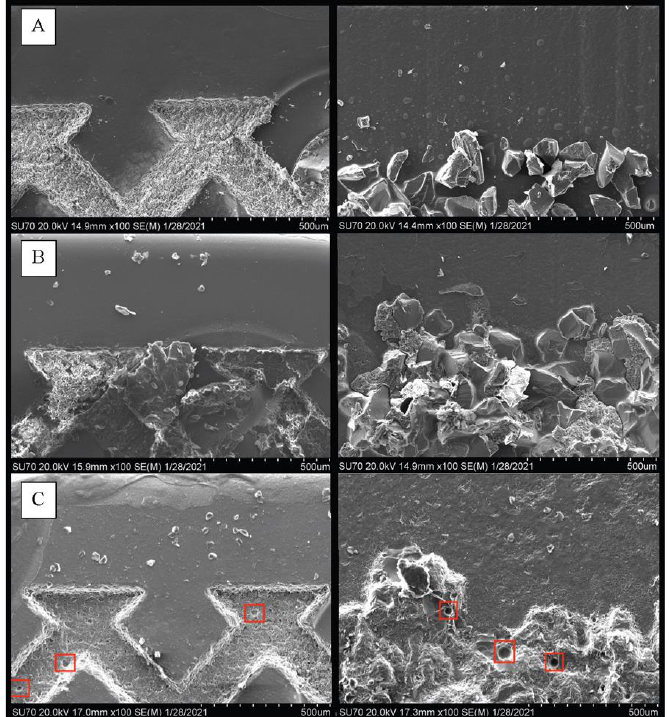
Figure 2. ( A ) SEM of unused SC (left) brackets showing the laser etched retentive feature, and RP (right) brackets showing the matt-textured, crystalline retentive feature. (100× initial magnification); ( B ) New SC (left) and RP (right) brackets following debonding. With SC, adhesive remnants par- tially cover the laser etched retention feature. With RP, gaps between the crystalline structures con- tain adhesive remnants. For both bracket types, minimal remnants of adhesive were present on the smooth surface. (100× initial magnification); ( C ) Rebonded and sandblasted SC (left) and RP (right) brackets (R-SB). The red squares show some of the damage done by the sandblasting particles. Note that, while the laser etched pattern appears intact in the SC brackets, much of the crystalline struc- ture has been removed with the RP brackets (100× initial magnification). Following debonding, when the retentive and smooth areas of the N brackets were examined by SEM (Figure 2), adhesive remnants were found to be associated with the retentive features, partially occupying the laser-etched pattern of the SC brackets, and fill- ing gaps between the crystalline structures of the RP brackets. The smooth surfaces had almost no remnants. With the R-SB groups, it was found that the retention features of the brackets had been damaged by sandblasting treatment, particularly the crystalline struc- ture of the RP brackets. 4. Discussion This study compared the SBS of two newly marketed ceramic brackets with differing adhesive retention features. The brackets were assessed when new and after rebonding following four different bracket base treatments. With the SC brackets, the median SBS of three groups fell into the clinically acceptable range (5.9–16 MPa): N (8.31 ± 3.84 MPa), R- NST (6.84 ± 4.36 MPa) and R-S (6.47 ± 3.14 MPa). With the RP brackets, the median SBS of two groups fell into the clinically acceptable range: N (8.35 ± 3.87 MPa) and R-S (6.24 ± 3.57 MPa). Consistent with previous studies [12,17,19,20], the N brackets had the highest overall median SBS, with no significant difference between the two types. The R-NST group with the SC bracket had the second-highest median SBS (6.84 ± 4.36 MPa), where the value was within the clinically acceptable bond strength range, whereas, with the RP